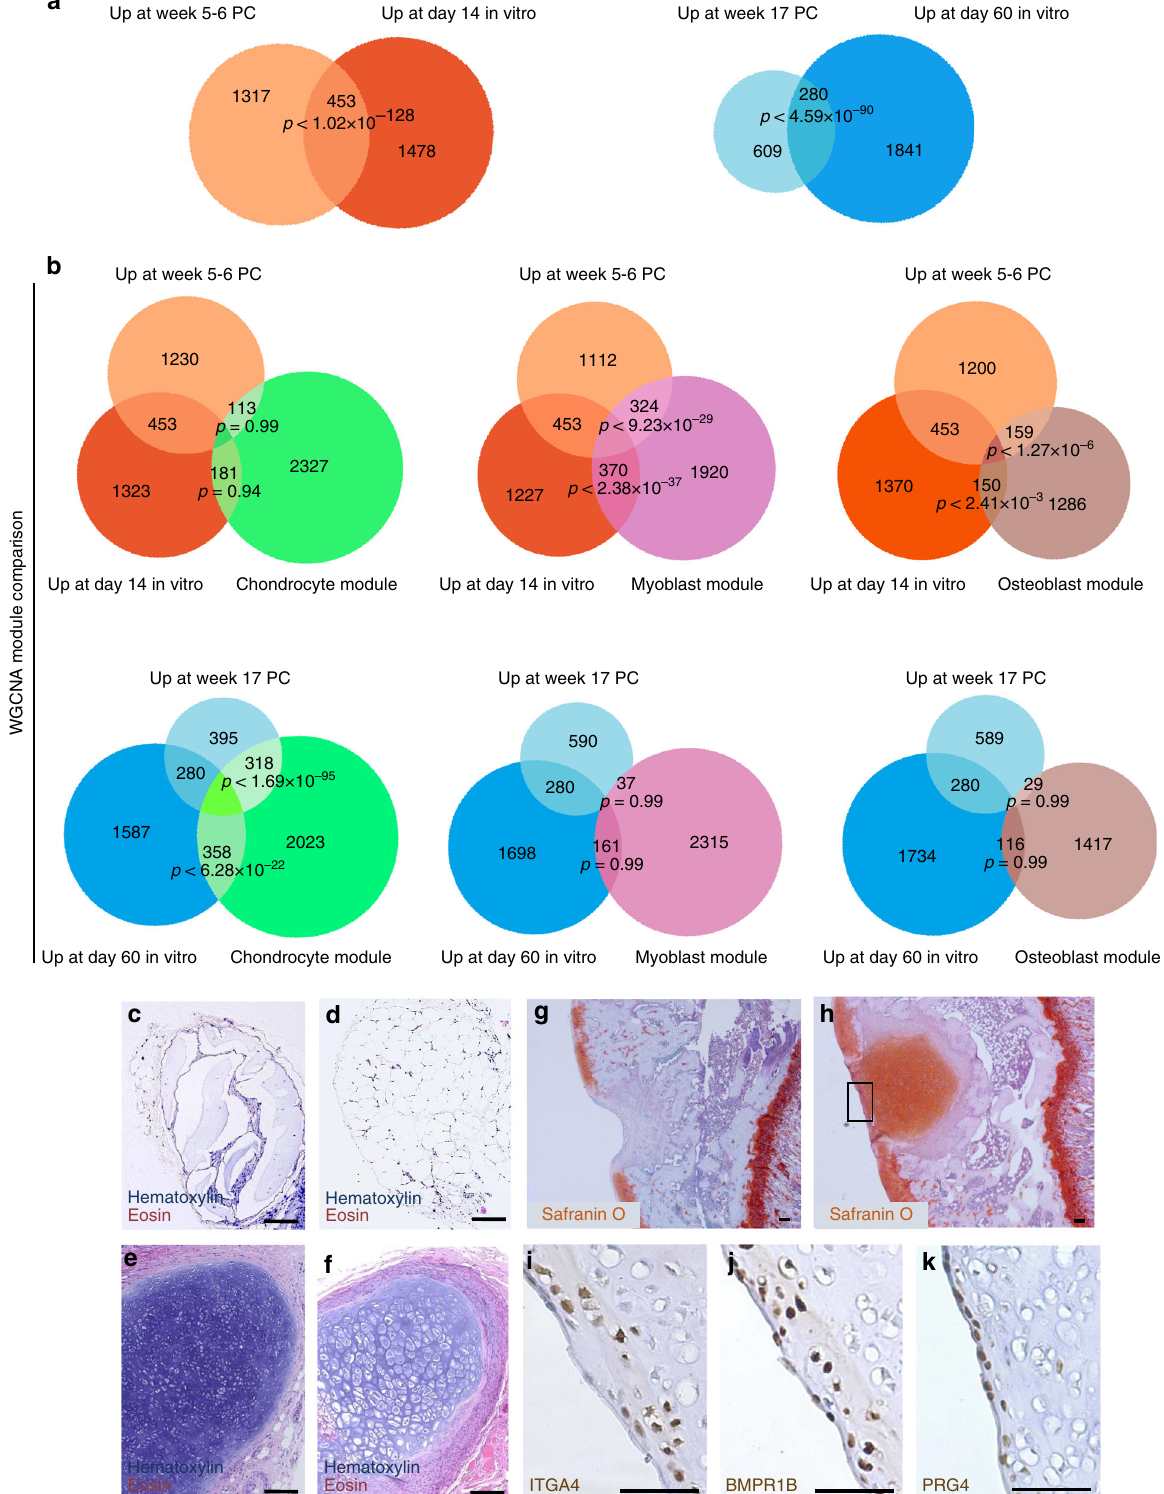
Fig. 7 In vitro chondrogenesis strongly resembles in vivo chondrocyte development. a Overlaps of genes signi fi cantly differentially enriched in early developmental stages (d14 in vitro and 5 – 6 WPC in vivo) and in later developmental stages (d60 in vitro and 17 WPC in vivo). b Inclusion of module- speci fi c genes (chondrocyte, green; myoblast, pink; osteoblast, brown) de fi nes the lineage relationship of overlapping genes in each comparison. Degrees of overlap should be compared between columns. c – f Representative hematoxylin and eosin stains of sections from chondrogenic cells injected into the fl anks of nude rats (c = 5 – 6 WPC; d = d14; e = 17 WPC; f = d60). g – k Focal defects were created in rat articular cartilage and either fi lled with